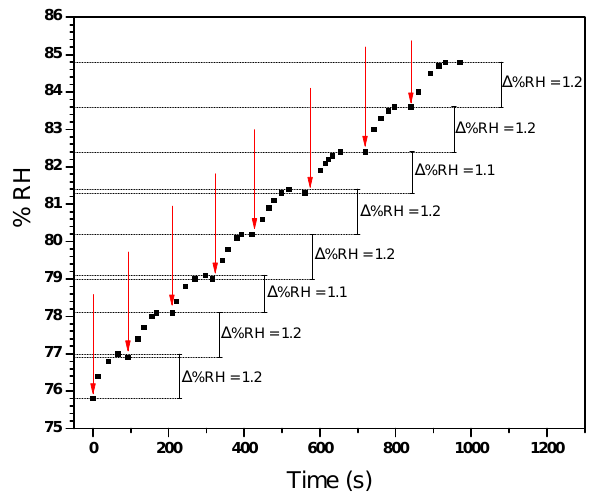
Fig. 2. Evolution of the relative humidity with time during the hot air inlet. Red arrows indicate the moment when air is